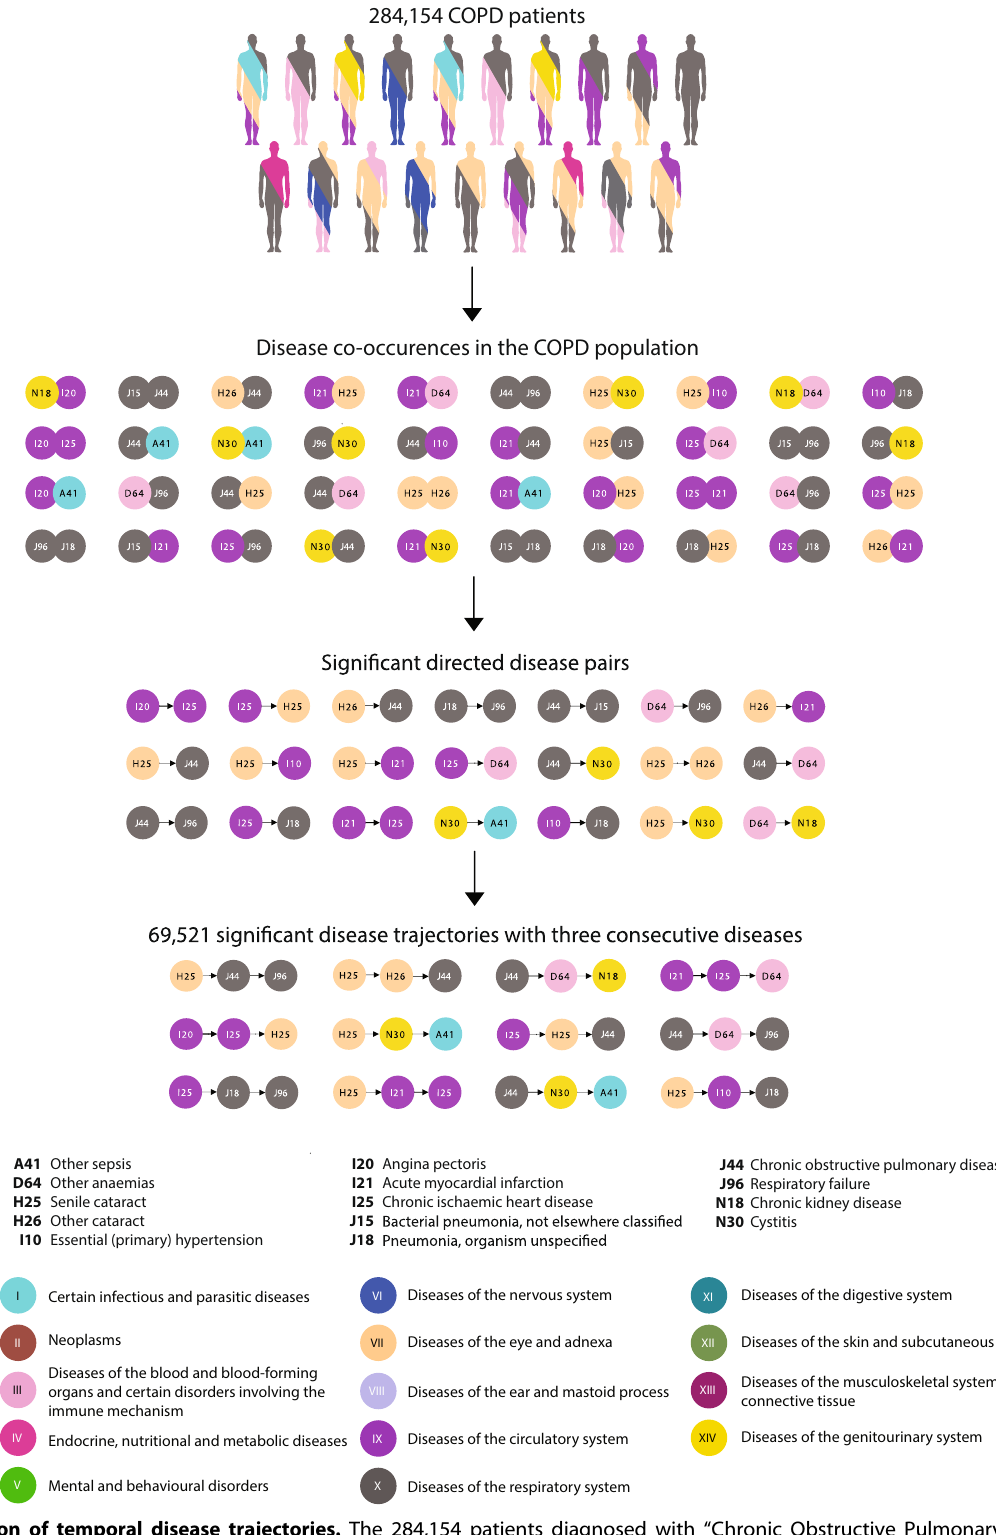
Fig. 8 Creation of temporal disease trajectories. The 284,154 patients diagnosed with “ Chronic Obstructive Pulmonary Disease ” (COPD) (ICD-10: J44) in the Danish population have different comorbidity pro fi les (indicated by different colours). Disease pairs in the COPD population that co-occur more often together than expected based on their individual frequencies are identi fi ed. Each of the disease pairs is then tested for a statistically signi fi cant direction, disease 1 before disease 2 or the other way around. All disease pairs with a signi fi cant direction are then combined into longer disease trajectories of three consecutive diseases. The 284,154 COPD patients yielded 69,521 signi fi cant temporal disease trajectories with three consecutive